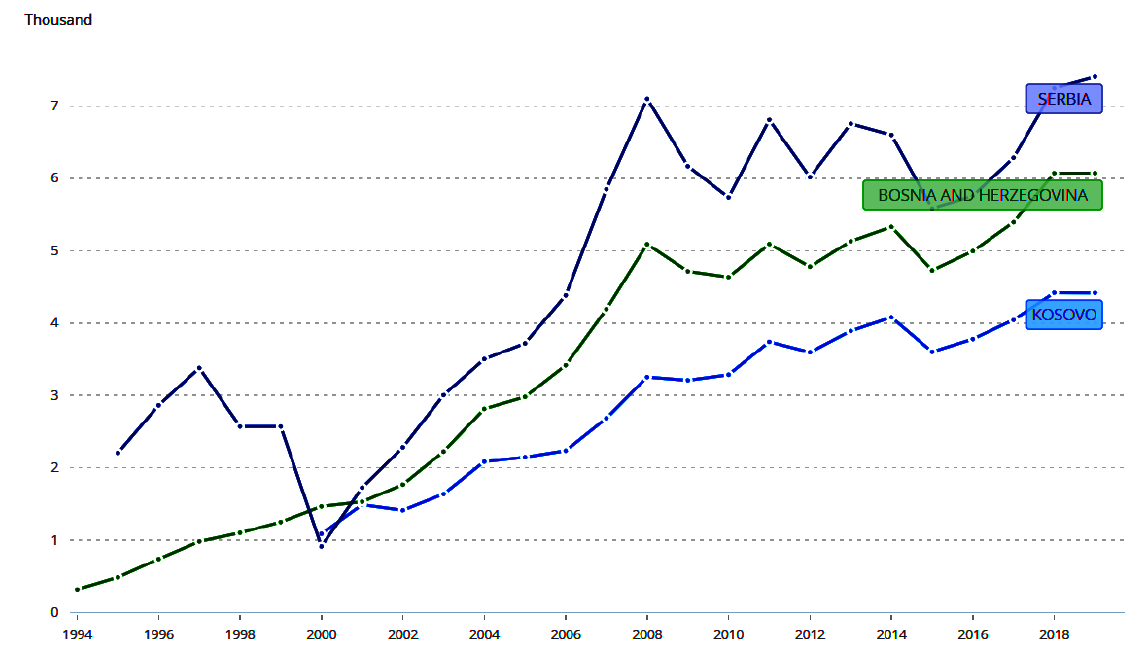
Figure 2. GDP per capita in thousands (current US$)